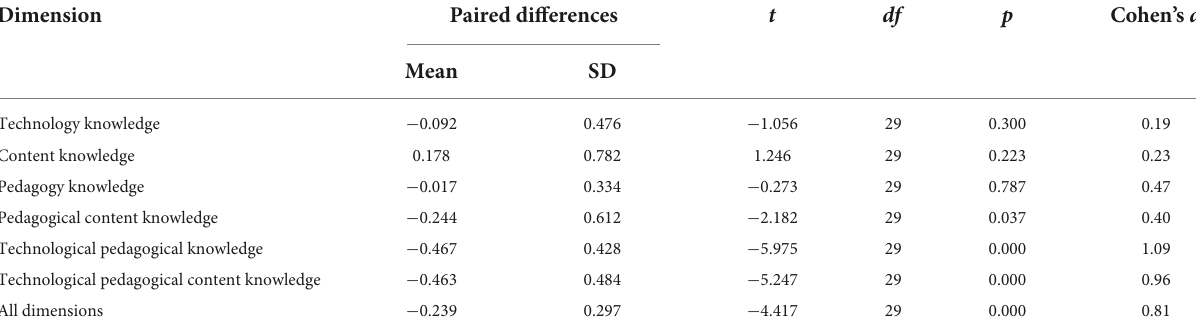
TABLE 5 The results of the paired-samples t -test. Dimension Paired